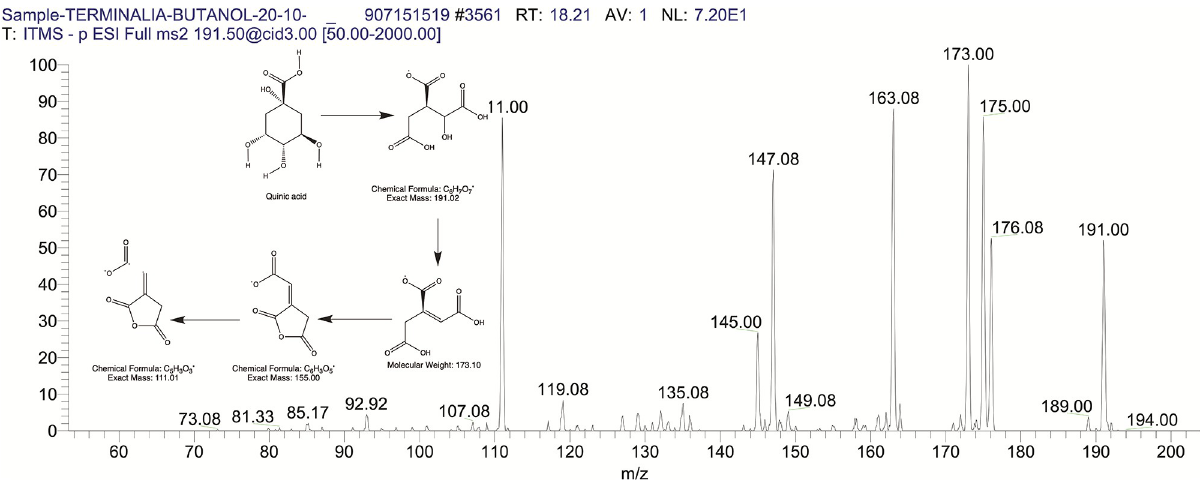
Fig 19. The mass spectrum of quinic acid and its fragmentation pattern.